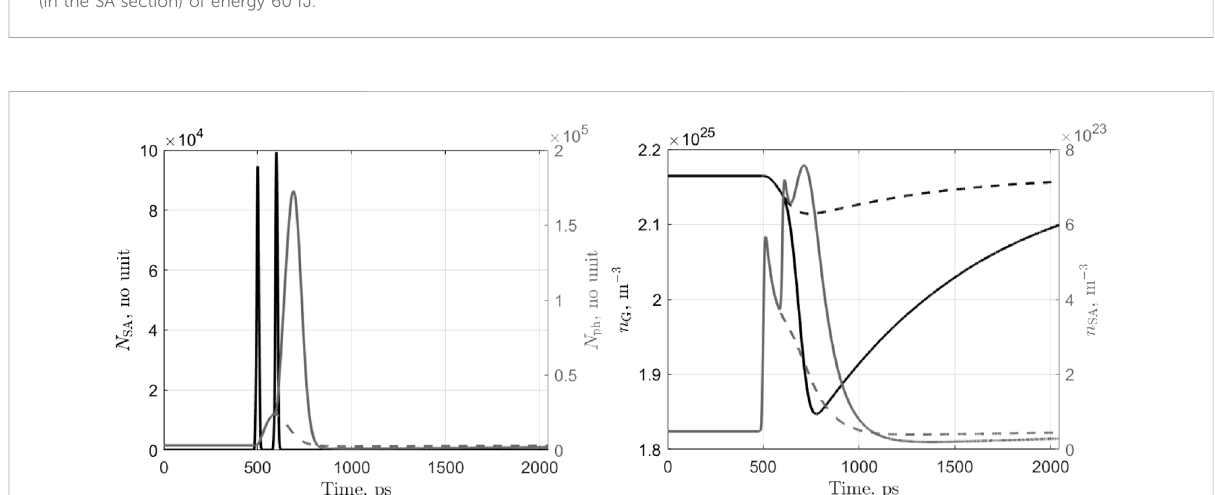
FIGURE 4 Timetracesofthephotons(left)andcarriers(right)ofthelaser-neuronunder i bias =13 mAanduponthearrivalat t =500psofanexitatorypulse (in the SA section) of energy 60 fJ.